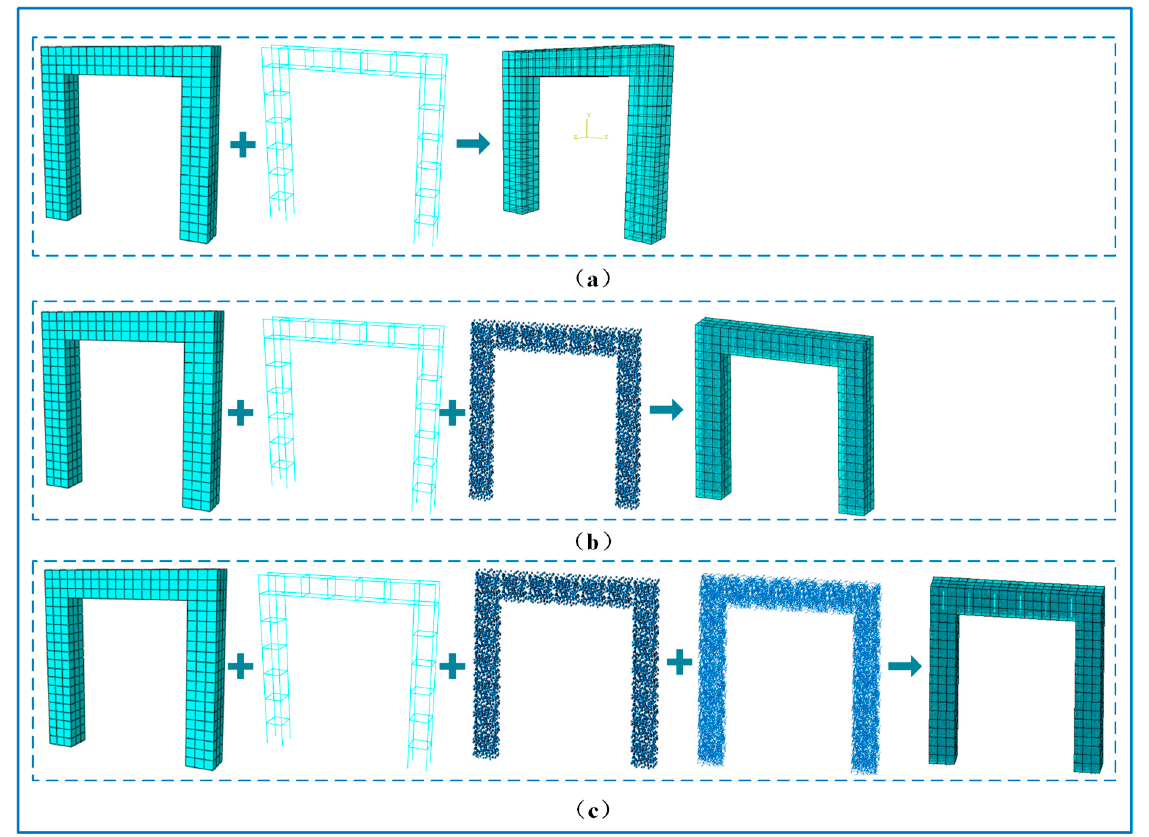
Figure 9. Finite element model of portal frame: ( a ) ordinary concrete frame model; ( b ) rubber concrete frame model; ( c ) PVA rubber concrete frame model.